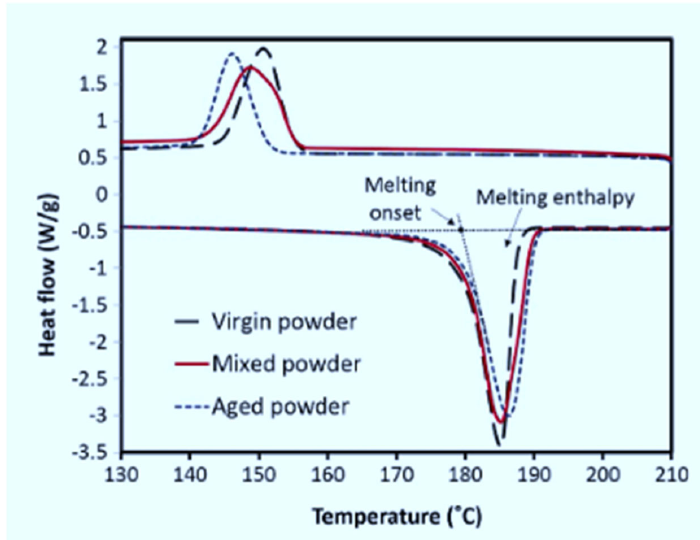
Figure 13. DSC thermogram for virgin, aged and mixed PA 12 powder [28].